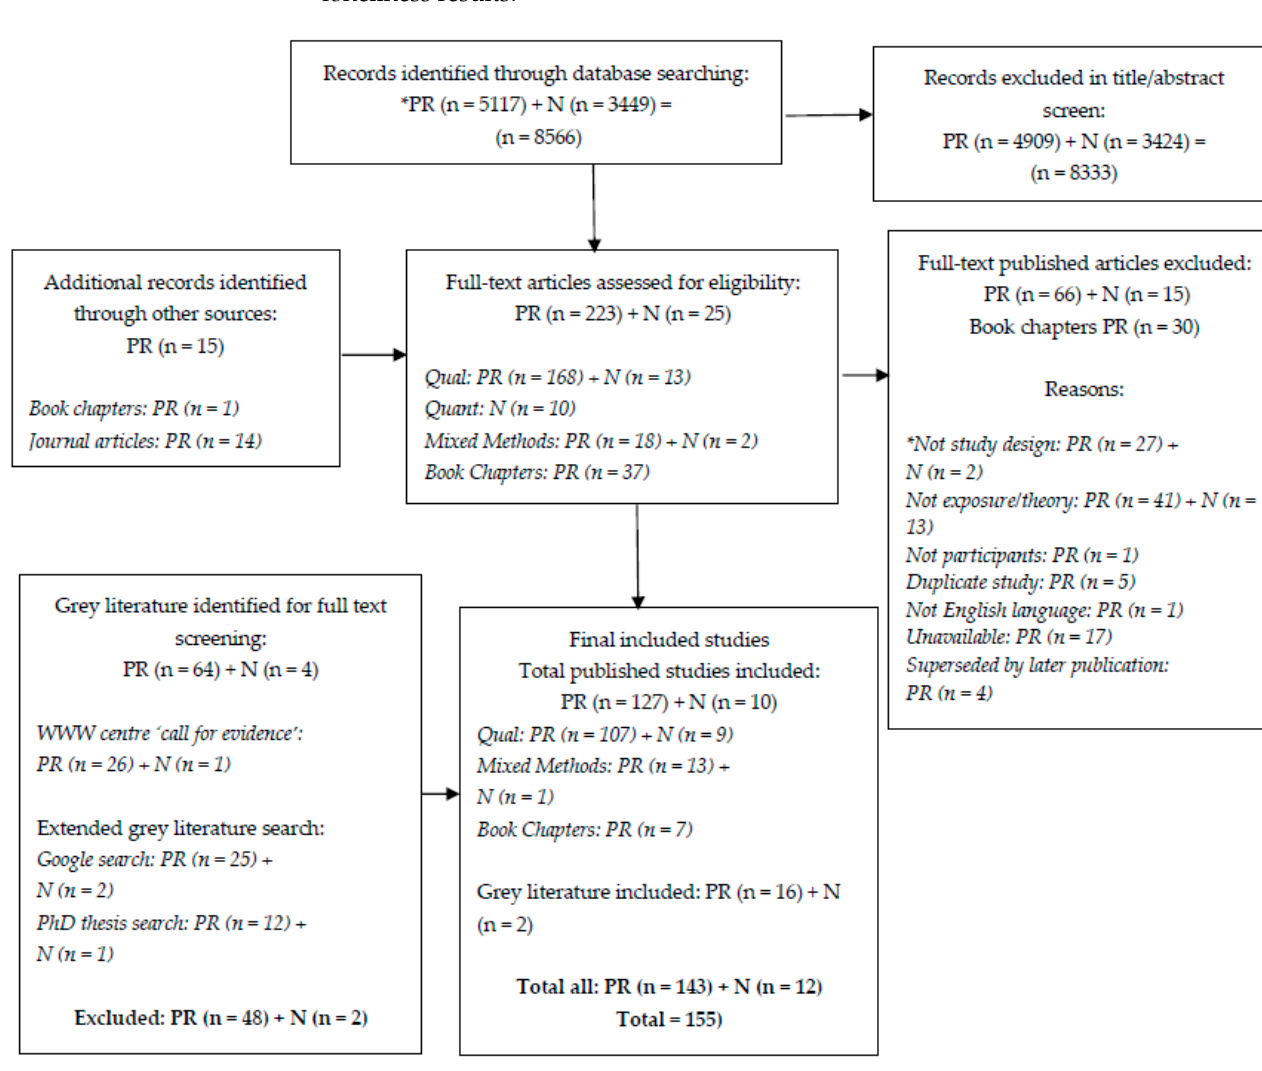
Figure 1. PRISMA flowchart.